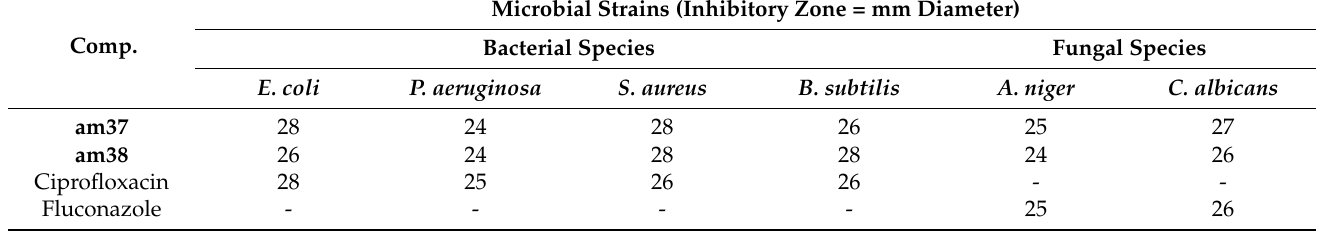
Table 16. Results of antimicrobial activity of the synthesized compounds (am37 – am38 ).